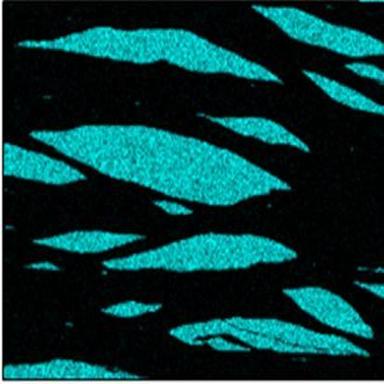
The EDS elemental mapping analysis results for the structure of accumulative fold-forged Mg/Ni composite material, indicating the composition of Mg-matrix and Ni-foil layers.